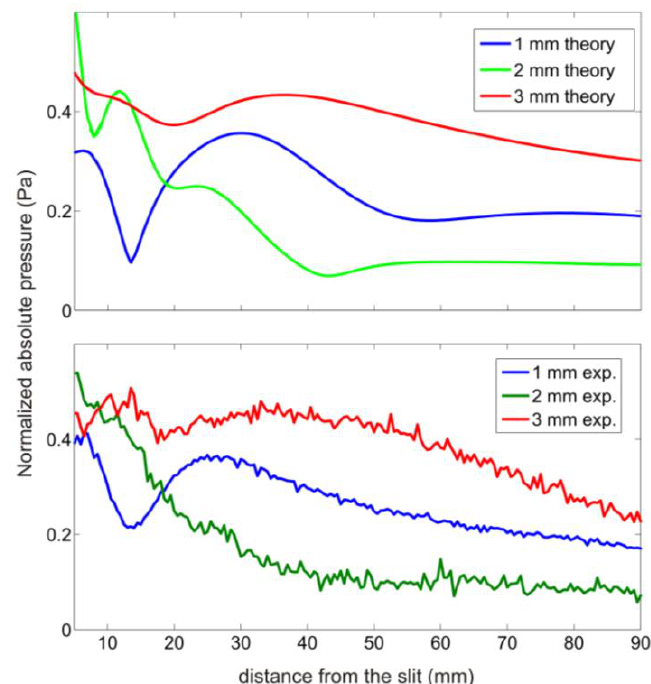
Figure 5. Pressure field at the line x = 0 of the corrugated plates considered. ( a ) Simulated results and ( b ) Experimental